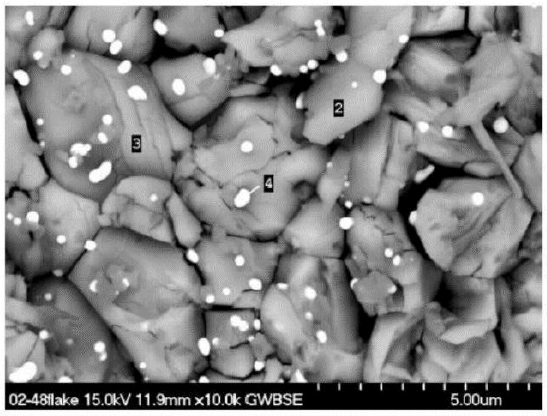
Figure 5. Characteristic large NiO grains in scales formed on high 12% Mo alloy 2-48 (0010). ( a ) SEM/SE image of sample surface; ( b ) SEM/BSE image of large spalled flake. 200 h cyclic oxidation at 1100 °C.